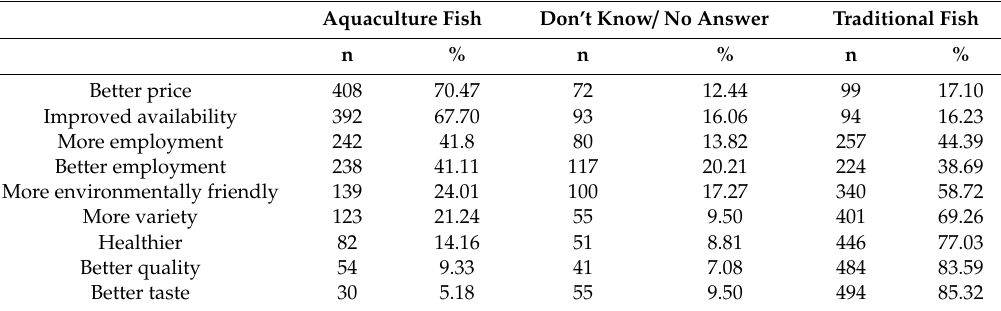
Table 5. Comparison between aquaculture fish and traditional